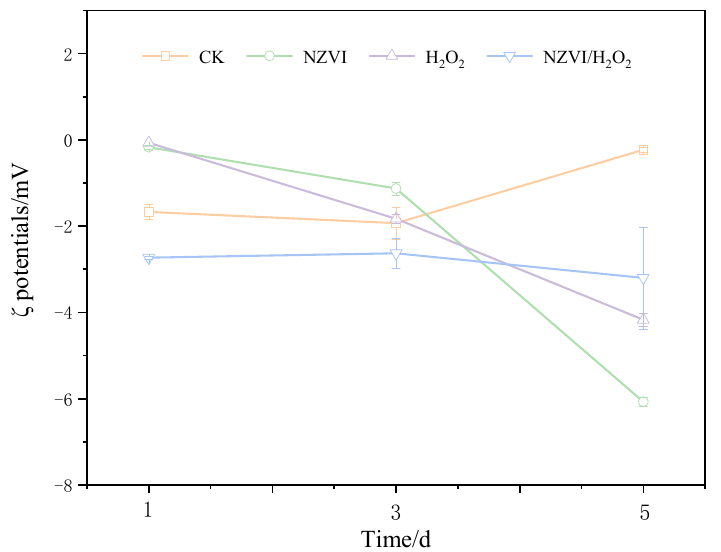
Figure 2. Effects of different treatments on the ζ potentials of M. aeruginosa . Mean ± standard deviation of three replicates is shown for each value.